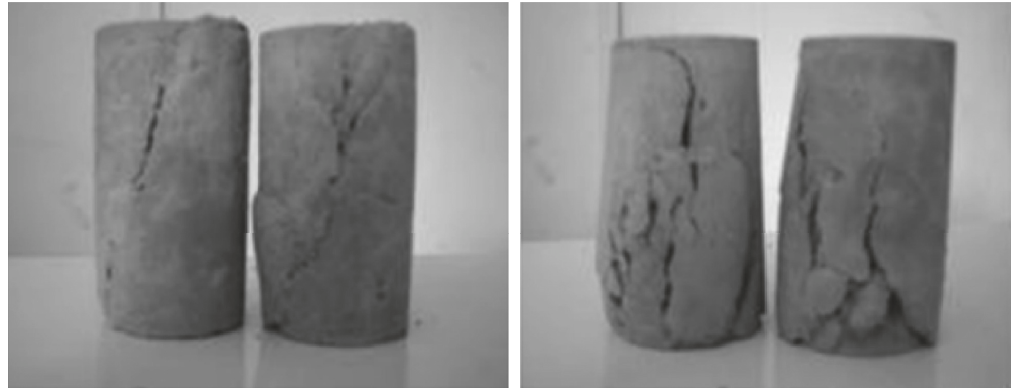
Figure 4: Two typical failure modes of cement soil samples, from Ou et al.